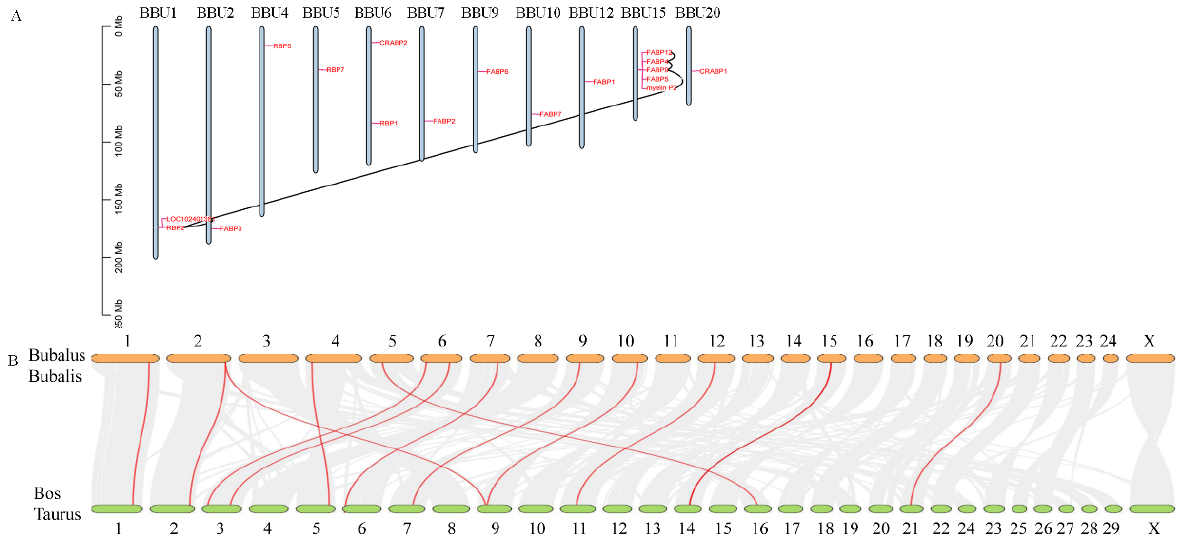
Figure 3. Gene duplication of buffalo FABP genes ( A ) and collinear analysis between buffalo and cattle ( B ) . A red line marks the orthologous FABP genes pairs between buffalo and cattle. Table 2. Ka/Ks ratios estimated in the present work for duplicated FABP genes in buffalo.